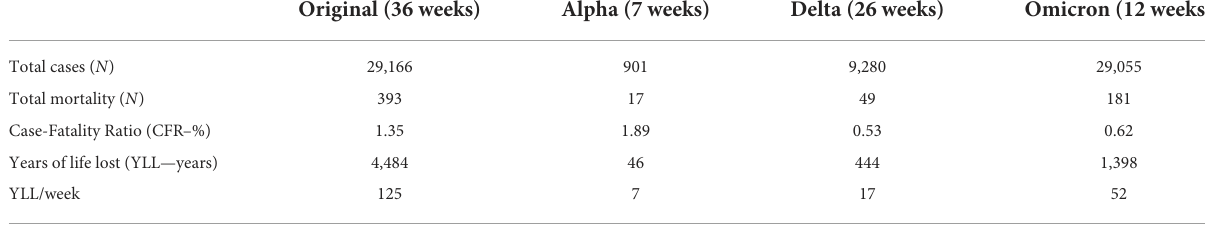
TABLE 1 Comparison of the four COVID-19 phases epidemiological outcomes.